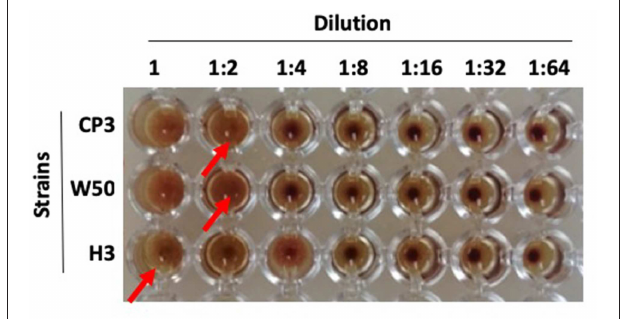
FIGURE 4 | Hemagglutination activity of Porphyromonas gingivalis strains CP3, H3, and W50. Hemagglutinin activities of P. gingivalis (W50, H3, and CP3) were assessed in cells serially diluted (from left to right) and incubated with sheep erythrocytes (2%) in a round-bottom microtiter plate. Dilution folds were listed on the top. Red arrows indicate the last dilution that showed full agglutination. The figure is representative of three biological